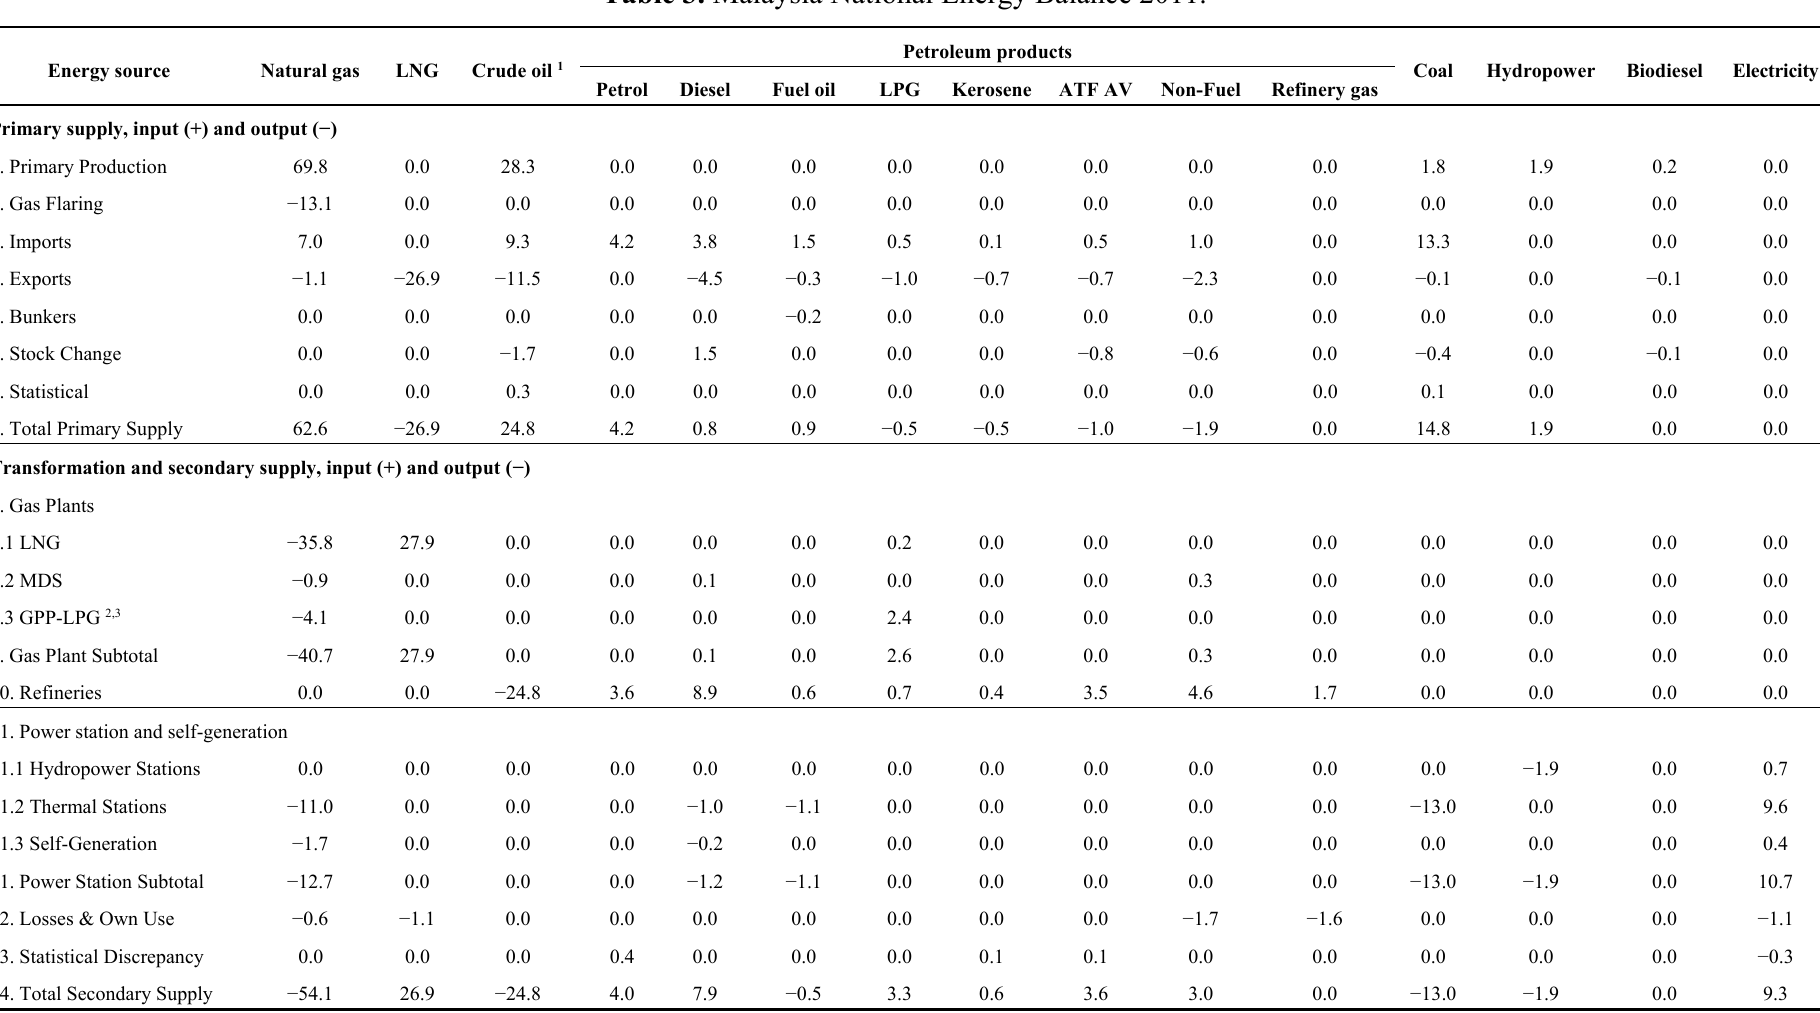
Table 3. Malaysia National Energy Balance